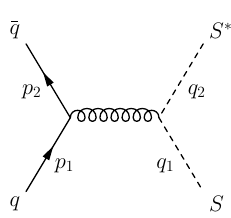
Figure 5 . Feynman diagram for the LO scalar pair production at hadron colliders via quark- antiquark